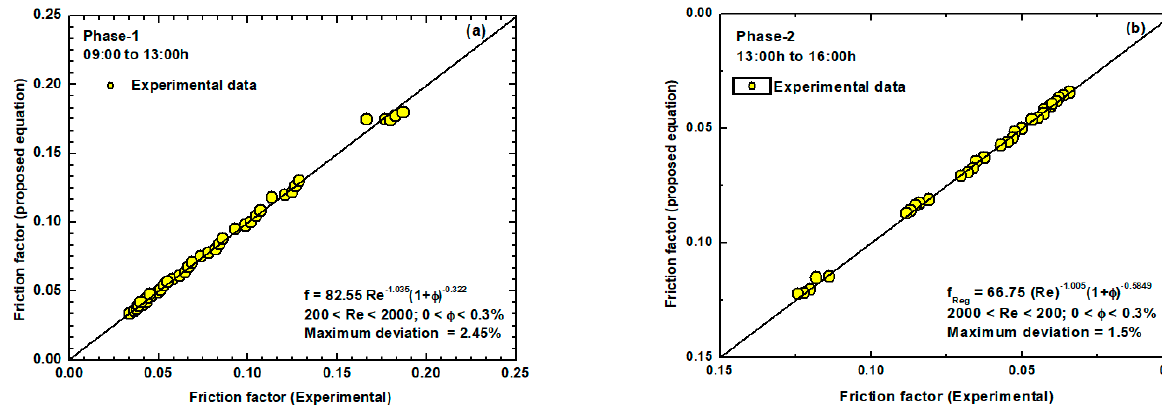
Figure 16. Experimental friction factor against suggested equation ( a ) Phase-1 and ( b ) Phase-2.